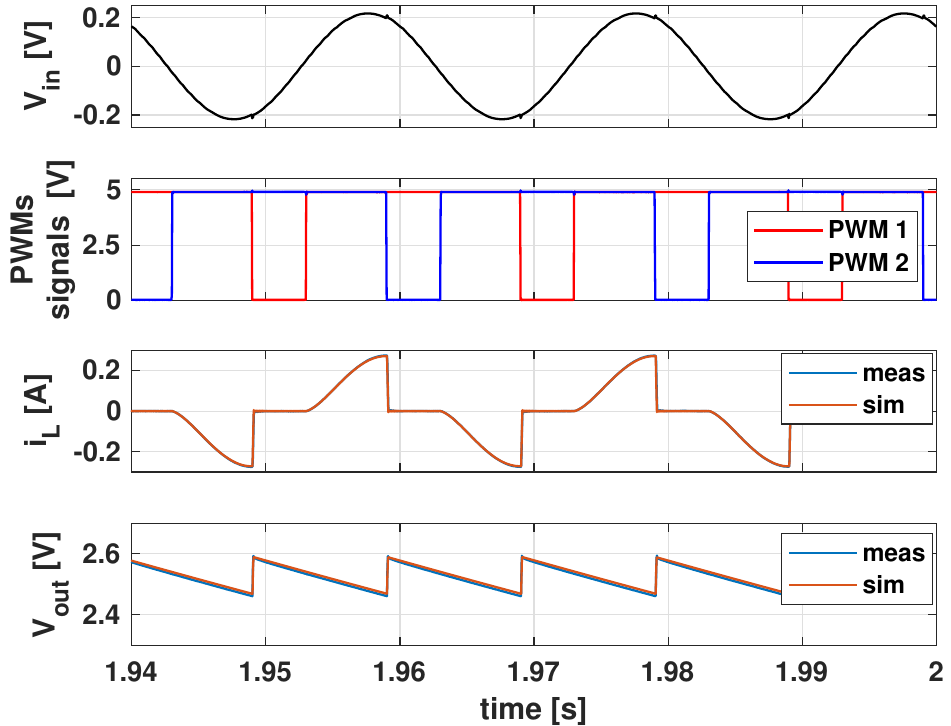
Figure 8. Steady − state signals over time at T D = 1% and D = 80%. Input voltage frequency f in = 50 Hz. From the top pane to the bottom one: measured input voltage, measured PWMs signals, measured and simulated inductor current, measured and simulated output